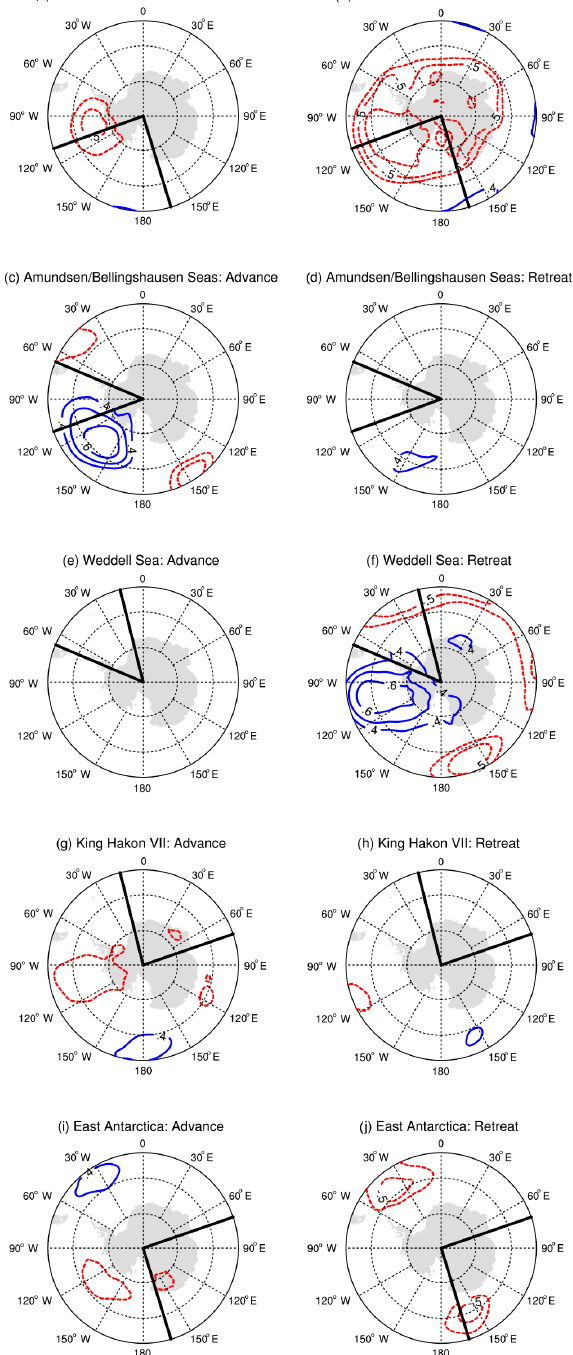
Figure 1. Cross-correlations (significant at 95%) of observed SIE with ERA-Interim SLP from 1979 to 2014 during advance (a, c, e, g, i) and retreat (b, d, f, h, j) . Red dotted contours indicate negative correlations, where a decrease in sea level pressure is associated with an increase in sea ice extent; blue contours indicate positive correlations, where a decrease in sea level pressure is associated with a decrease in sea ice extent. Black lines show sector bound-